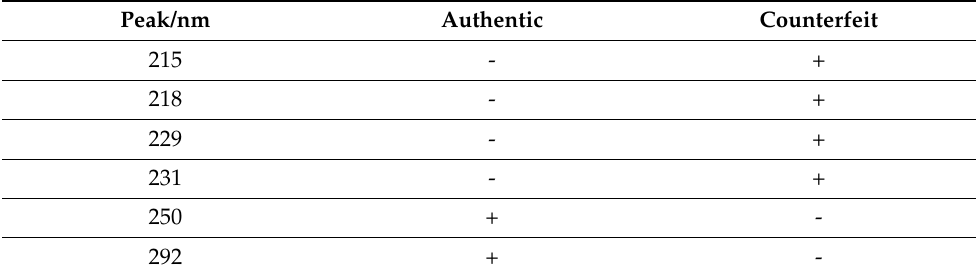
Table 4. List of main peaks which are missing in Zone A of the authentic 1 USD banknote and